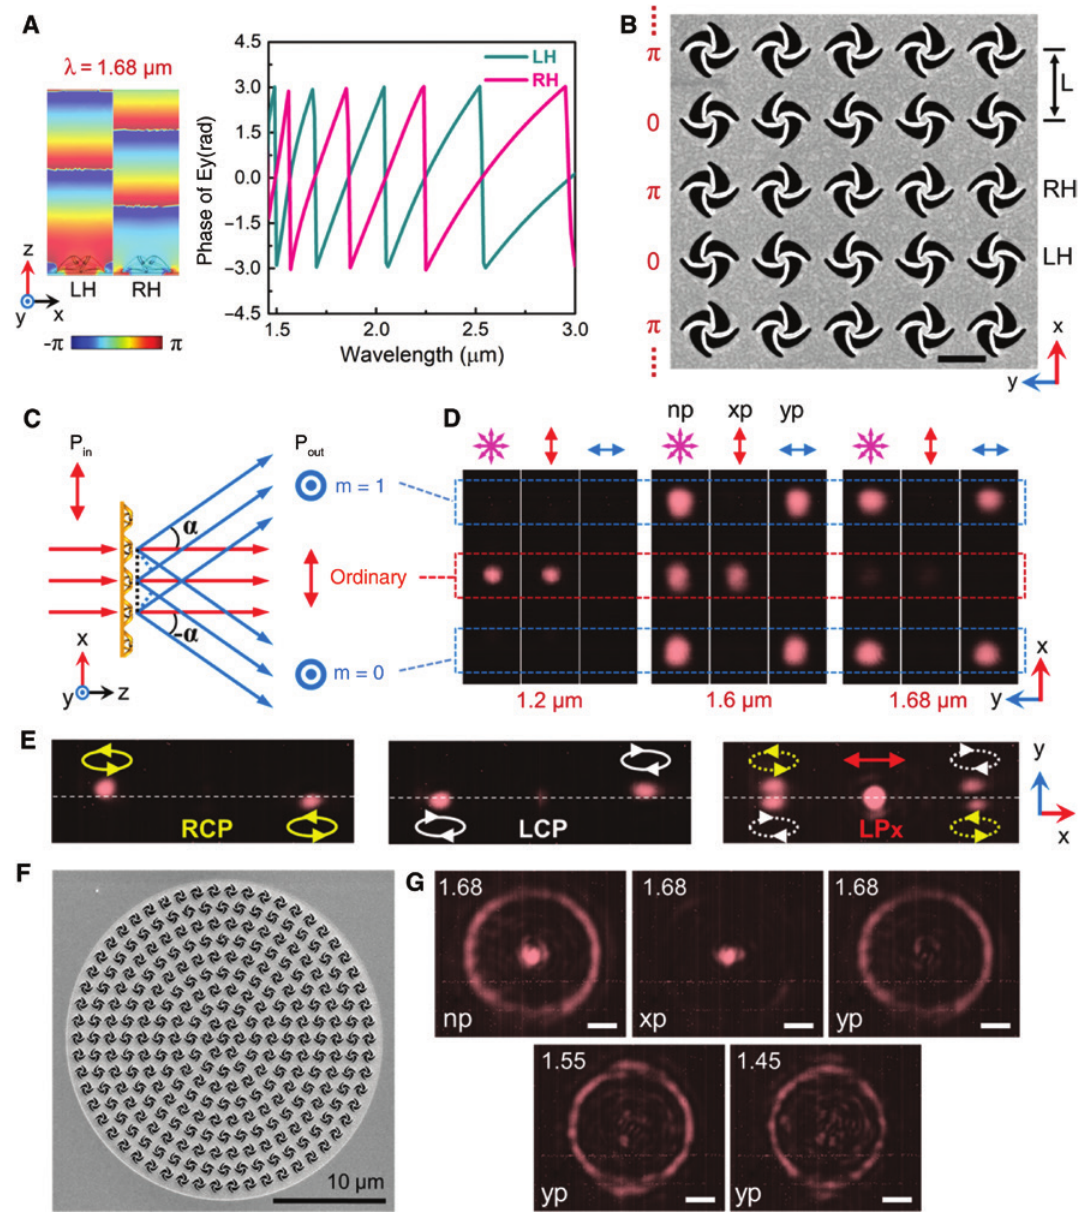
Figure 10: Phase and polarization manipulation [40]. (A) Phase diagram and phase spectra of the transmitted y -polarized electric-field ( E ) under x -polarized incidence, for pinwheels with y LH and RH rotation, respectively. The phase differences between LH and RH remain constant around π for all wavelengths above the lattice period of 1.45 μ m. (B) Top-view SEM image of a linear grating in which the LH and RH pinwheels are fabricated alternately along the x -direction. Under x -polarized incidence and for y -polarized transmission, there is a phase shift of π along the x -direction, as noted at the left side of the SEM image. Scale bars: 1 μ m. (C) Schematic of the diffraction properties of the linear grating under x -polarized incidence. The converted y -polarized (cross-polarization) light is diffracted with angle – α and α for m = 0 and 1, respectively. (D) CCD camera images of the transmitted light spots at wavelengths 1.20, 1.60, and 1.68 μ m, respectively, under detection with no polarization (np), x -polarization (xp), and y -polarization (yp). (E) CCD images of the spots of the diffracted (left) RCP and (middle) LCP beams under the illumination with LCP and RCP incident light, respectively. (right) CCD images of the beam spots with both incident and detection polarization aligned along the x -direction. Dashed circles indicate the positions of the equivalent RCP and LCP diffraction spots. The illumination power and imaging time were increased compared to other images. (F) Top-view SEM image of a circular grating with radial separation of 1.45 μ m. (G) CCD camera images of transmitted light with np, xp, and yp detections under x -polarized incidence at wavelengths 1.68, 1.55, and 1.45 μ m,